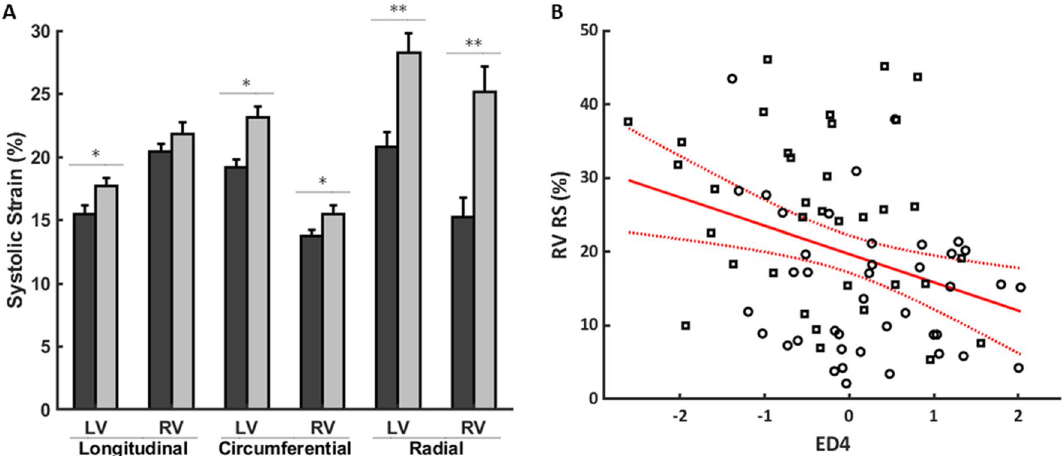
Figure 4. Geometric strain analysis. ( A ) Summary systolic strains (%) grouped by PVR status (PVR: dark gray bars; No-PVR: light gray bars). Data are reported as mean ± standard error. Systolic CS and LS are conventionally negative, but their absolute values are shown for simpler interpretation. Systolic strains that have significant associations with PVR status after accounting for sex, type of repair, time after repair, and BSA are denoted with symbols (* p < 0.05; ** p < 0.01). ( B ) Univariate regression model between RV RS (%) and ED4 (black circles: PVR; black squares: No-PVR; red solid line: linear fit; red dotted lines: 95% confidence bounds; p < 0.01; r = 0.33). LV Left ventricular, RS Radial strain, RV Right